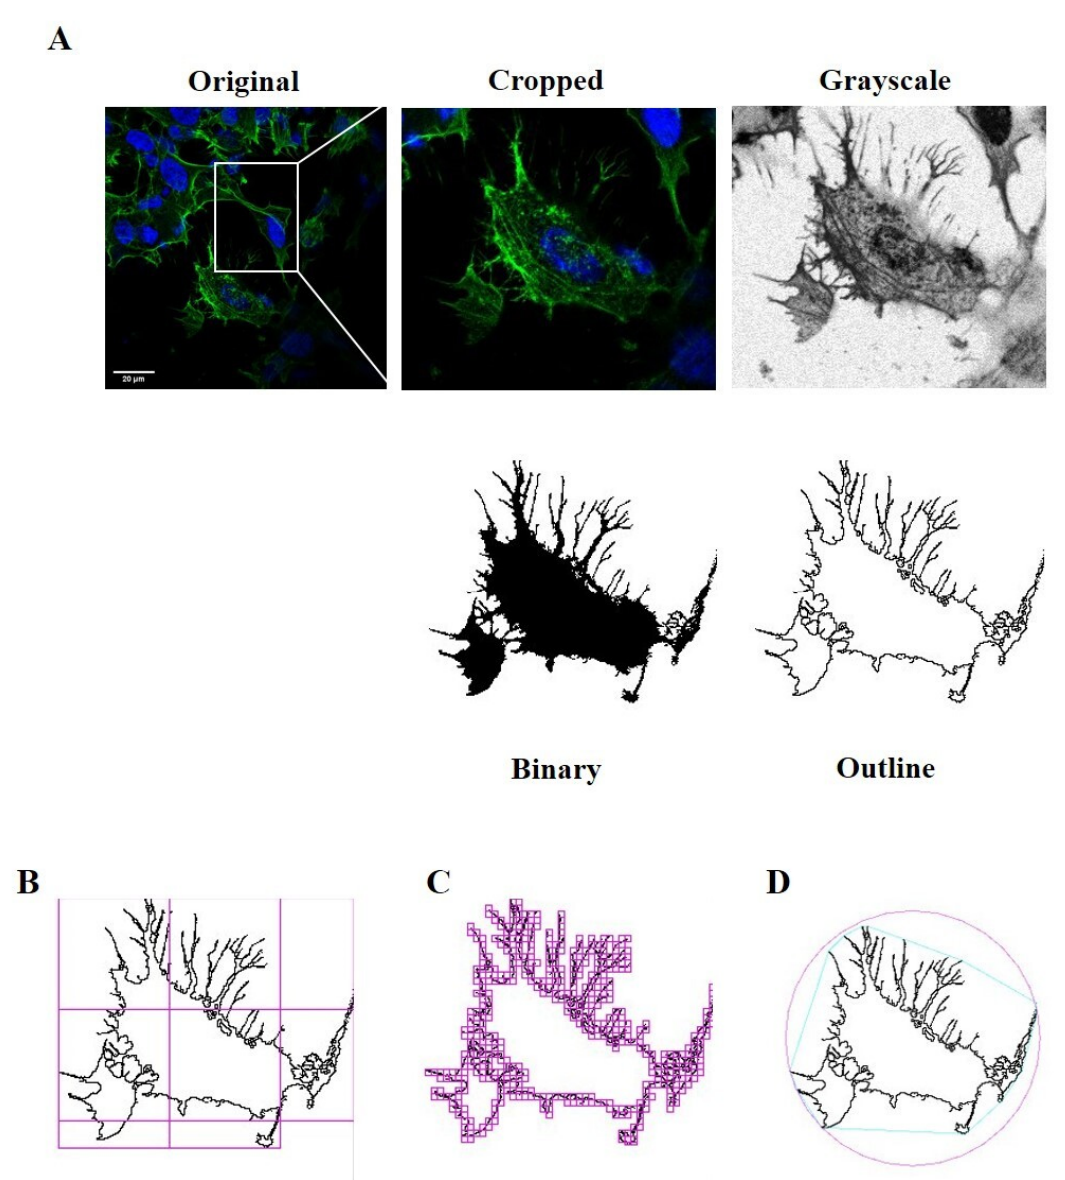
Figure 13. FracLac Analysis application to quantify cellular morphology. ( A ) Representative process applied to obtain an outlined single cell for FracLac plugin. After selecting a cell in the photomi- crograph (63 × magnification), the image was cropped and modified to remove noise and enhance the background. The image was then processed to obtain an 8-bit grayscale microphotograph, and binarized. Binary image was manually edited to clear the background and to join all branches, and finally outlined. FracLac quantifies cell complexity and shape with a box counting method which permits quantifying fractal dimension and lacunarity ( B ), perimeter and area ( C ), and the maximum span across the convex hull ( D ) by drawing a convex hull (pink) and a bounding circle